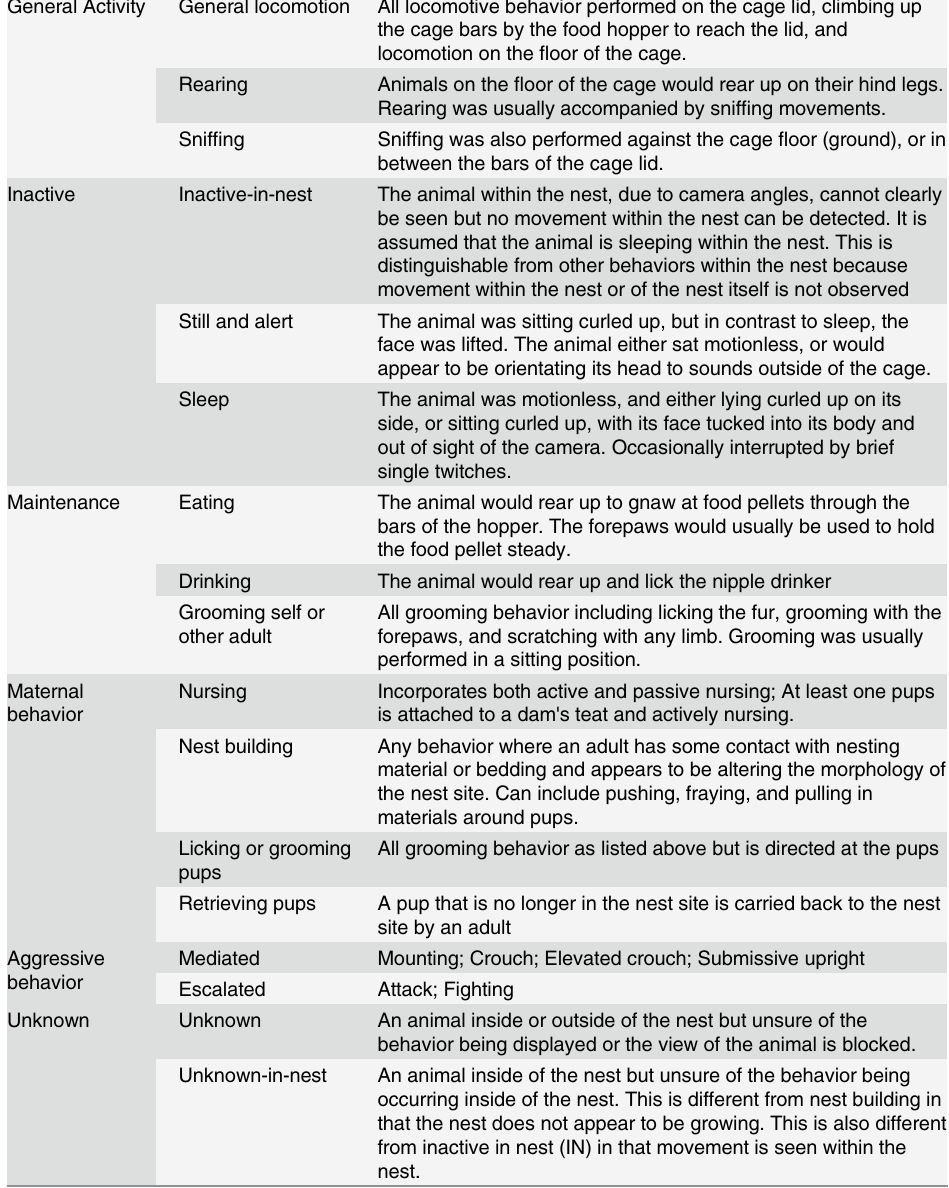
Table 3. General behavioral budget